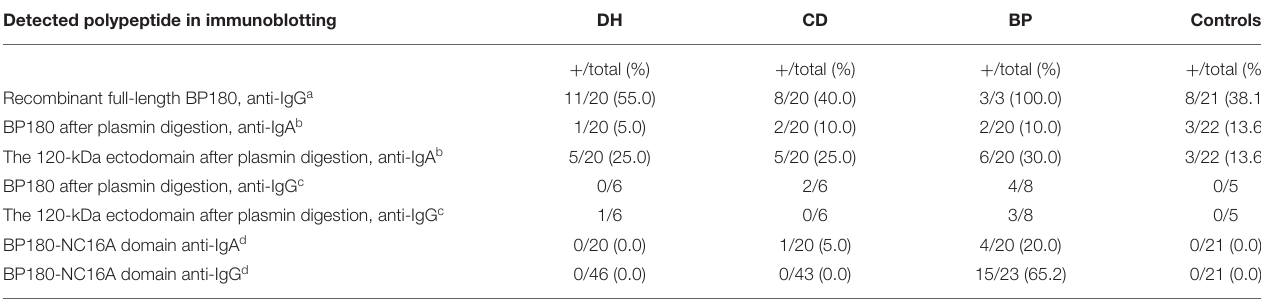
TABLE 1 | Immunoblotting of DH, CD, BP, and control sera against full-length and plasmin-digested BP180, and the BP180-NC16A domain. Detected polypeptide in